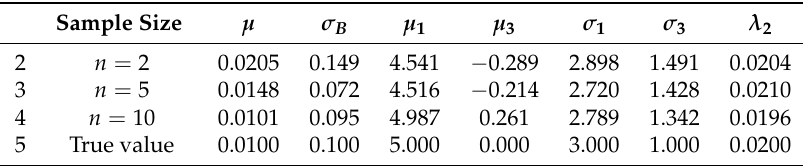
Table 2. The parameters estimation with different sample